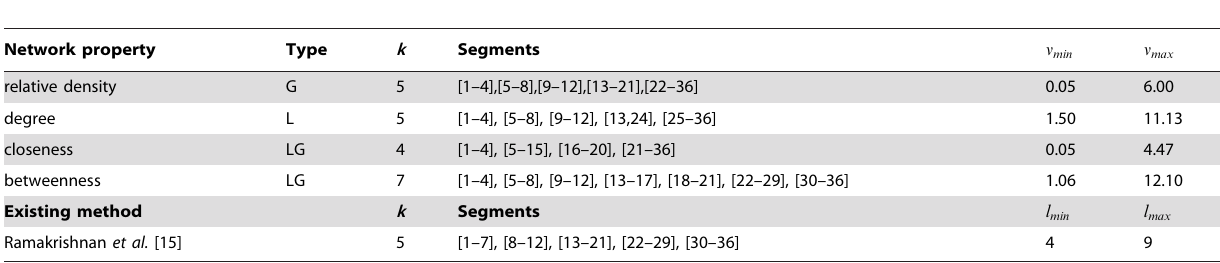
Table 1. Optimal segmentation for synthetic